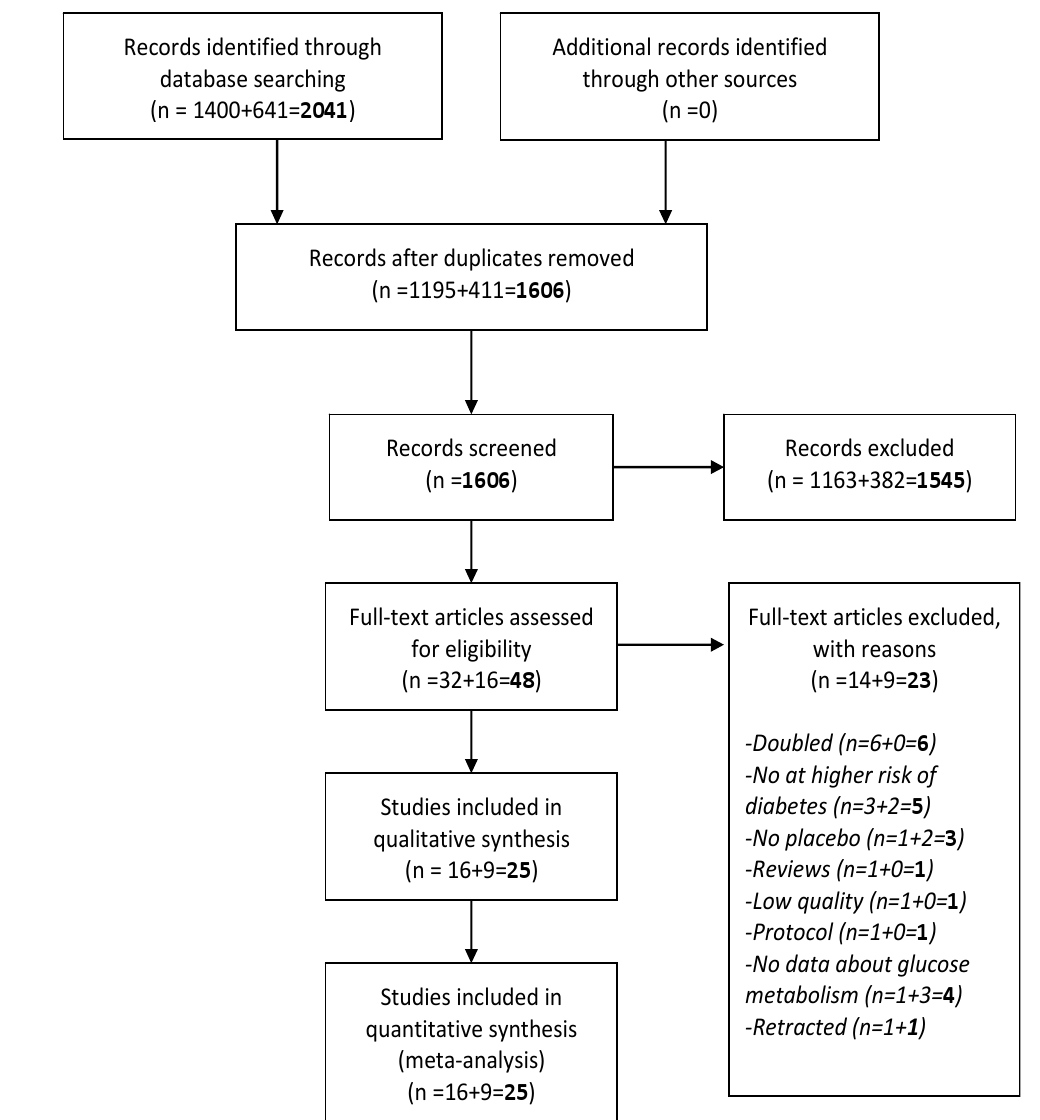
Figure 1. PRISMA flow-chart.